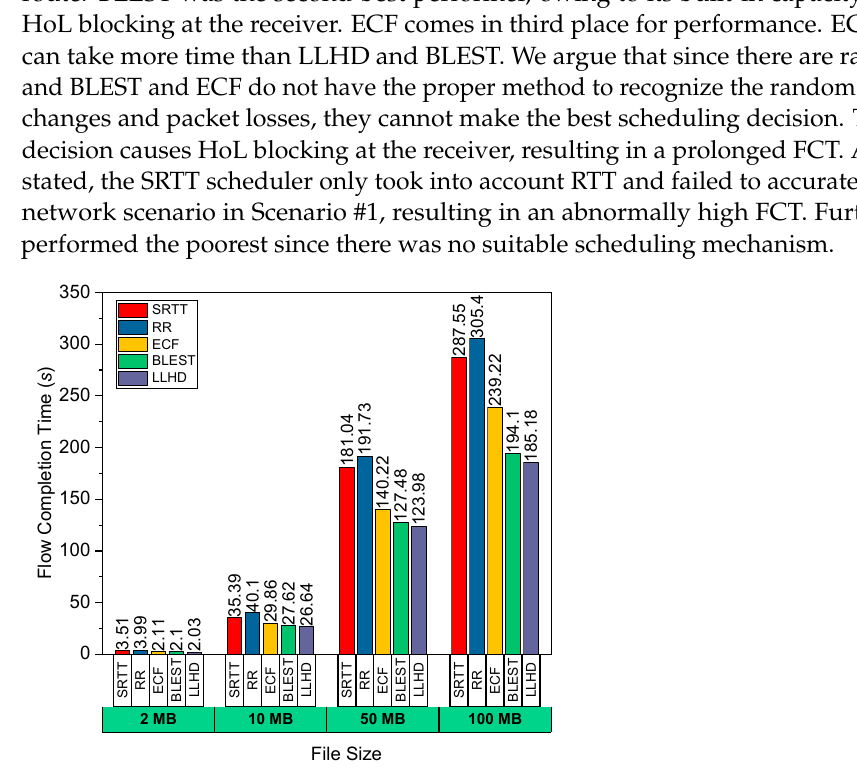
Figure 2. Performance evaluation of the considered schedulers in terms of FCT for variate file size in Scenario #1.